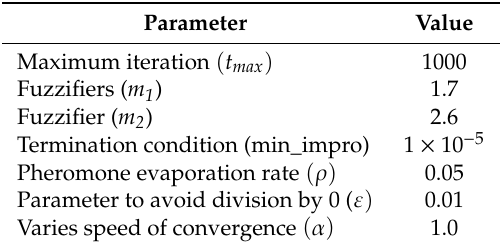
Table 1. Parameter initialization for spIT2FCM-ACO.